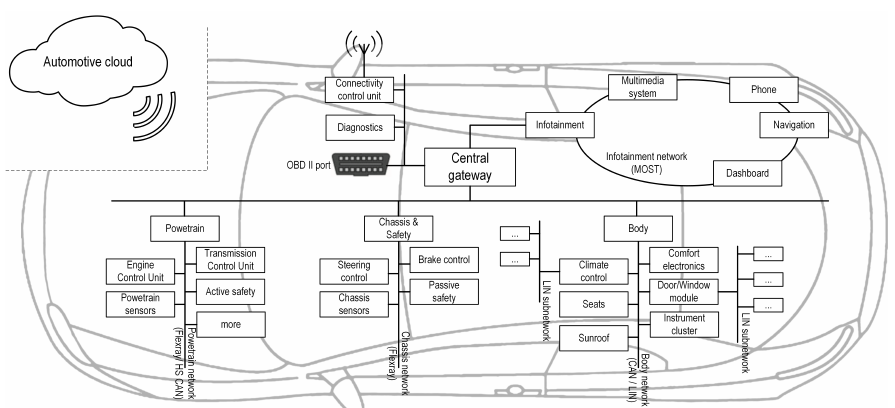
Figure 1. Internal architecture of the modern